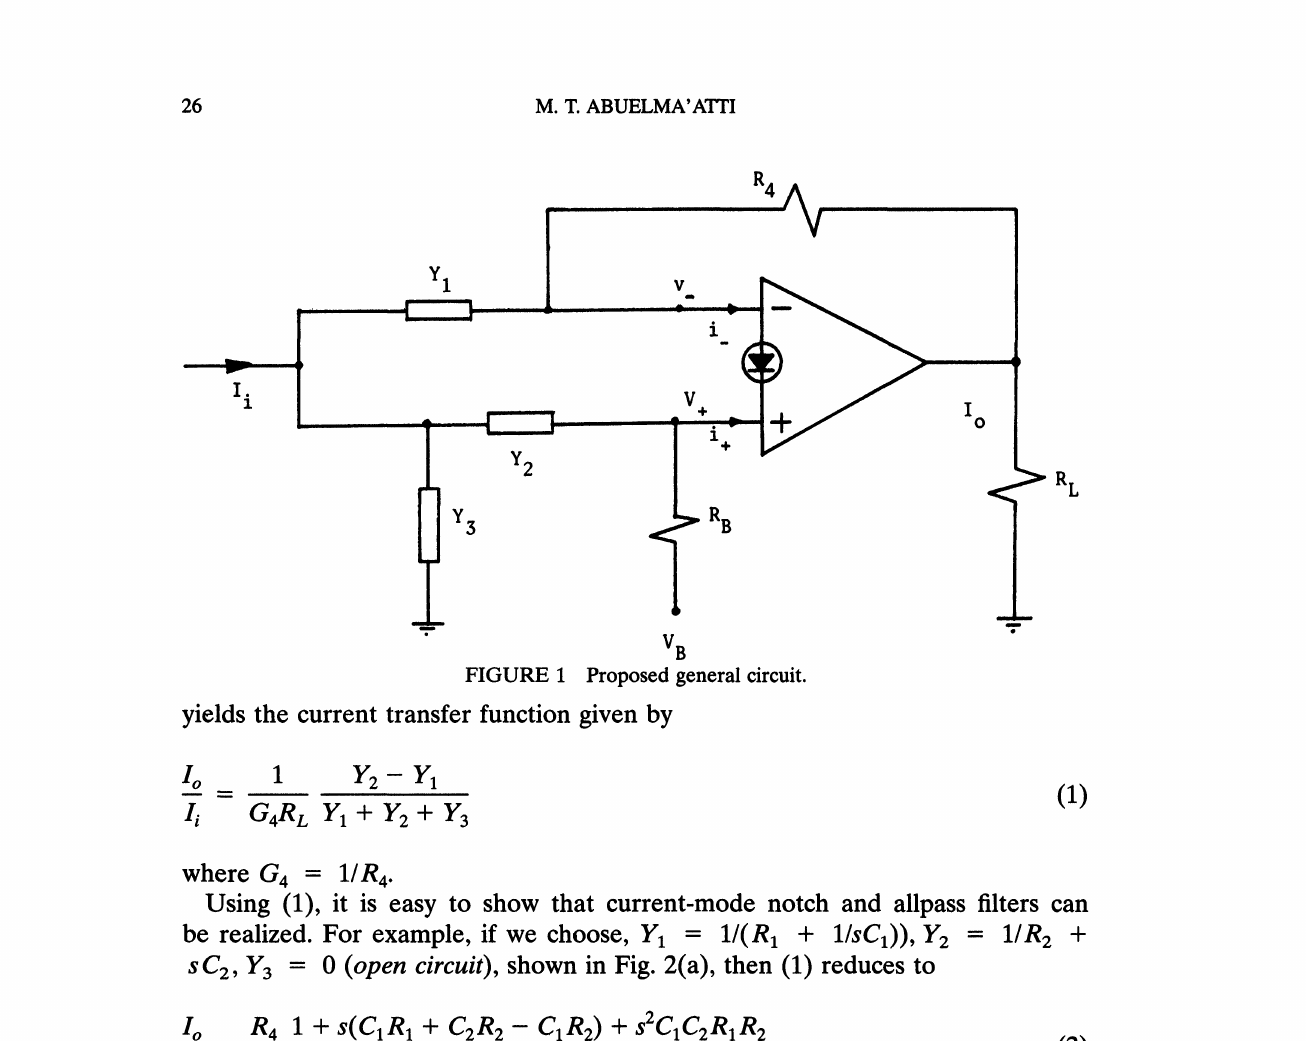
FIGURE 1 Proposed general